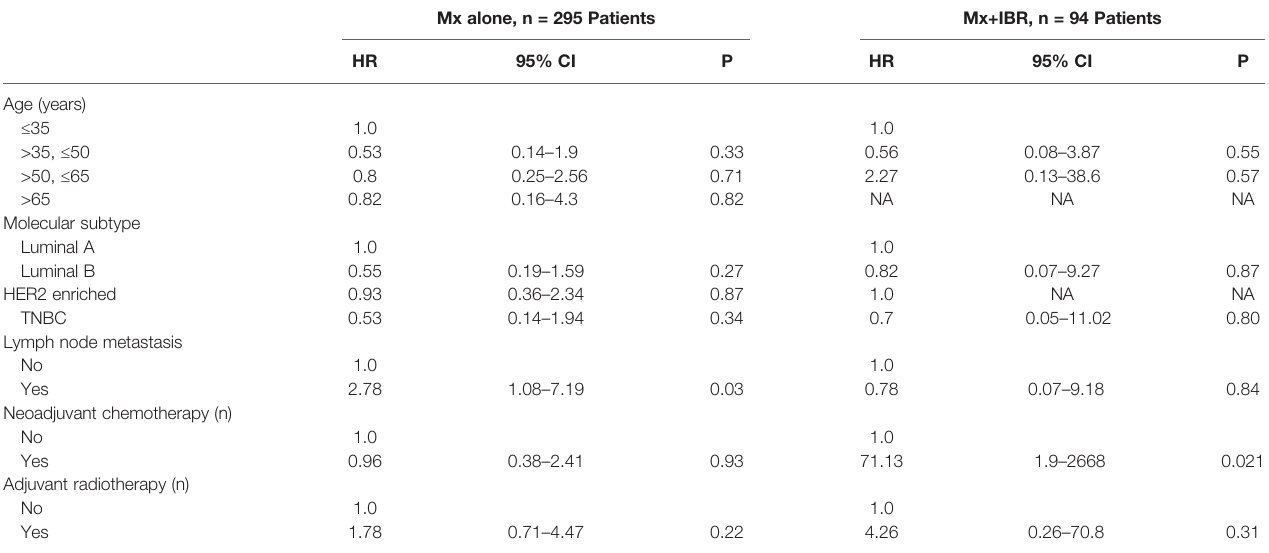
TABLE 5 | Multivariate Cox regression analysis of distant metastasis after breast surgery. Mx alone, n = 295